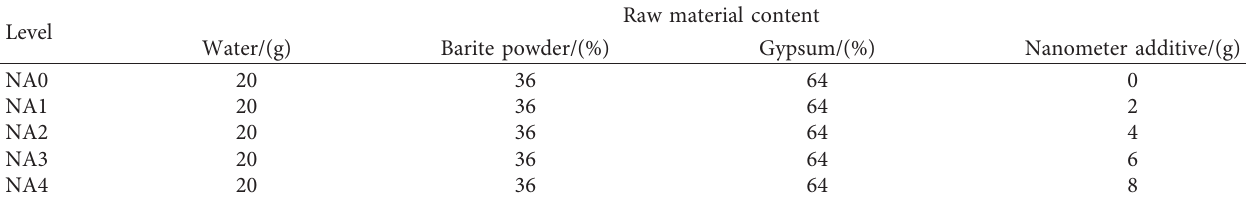
Table 3: The mixture ratio of similar materials with different dosages of nanoadditives. Note . Quality of Barite powder +Quality of Gypsum � 400g.